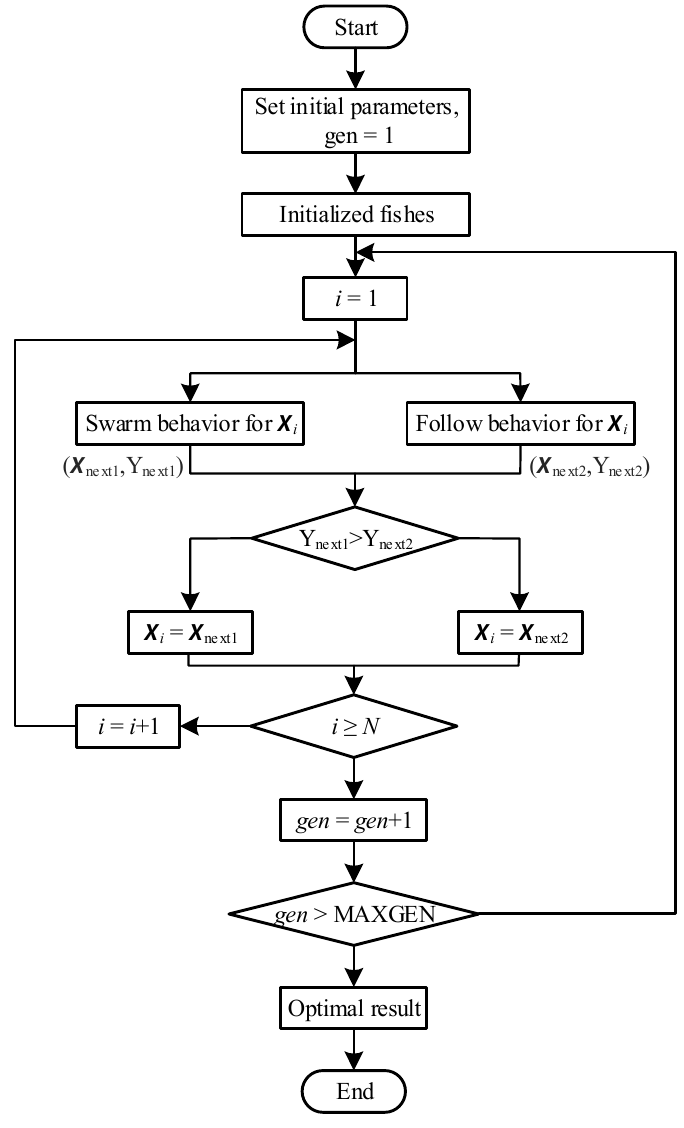
Figure 18. Flowchart of the AFSA.